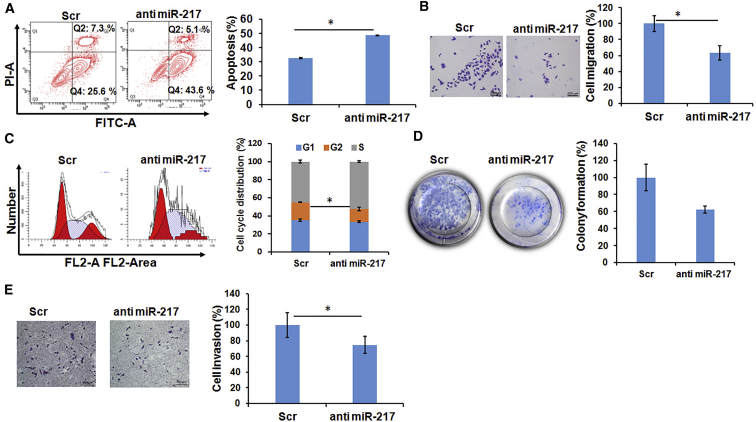
Tumorigenic Effect of miR-217The inhibition of miR-217 (A) increases apoptosis, (B) decreases cell migration, (C) increases the percentage of the cell population in S phase, (D) decreases colony formation, and (E) decreases invasion in the HDMB03 cell line. Data are shown as the mean ± SD of three separate experiments (Student’s t test; *p < 0.05; n = 3).